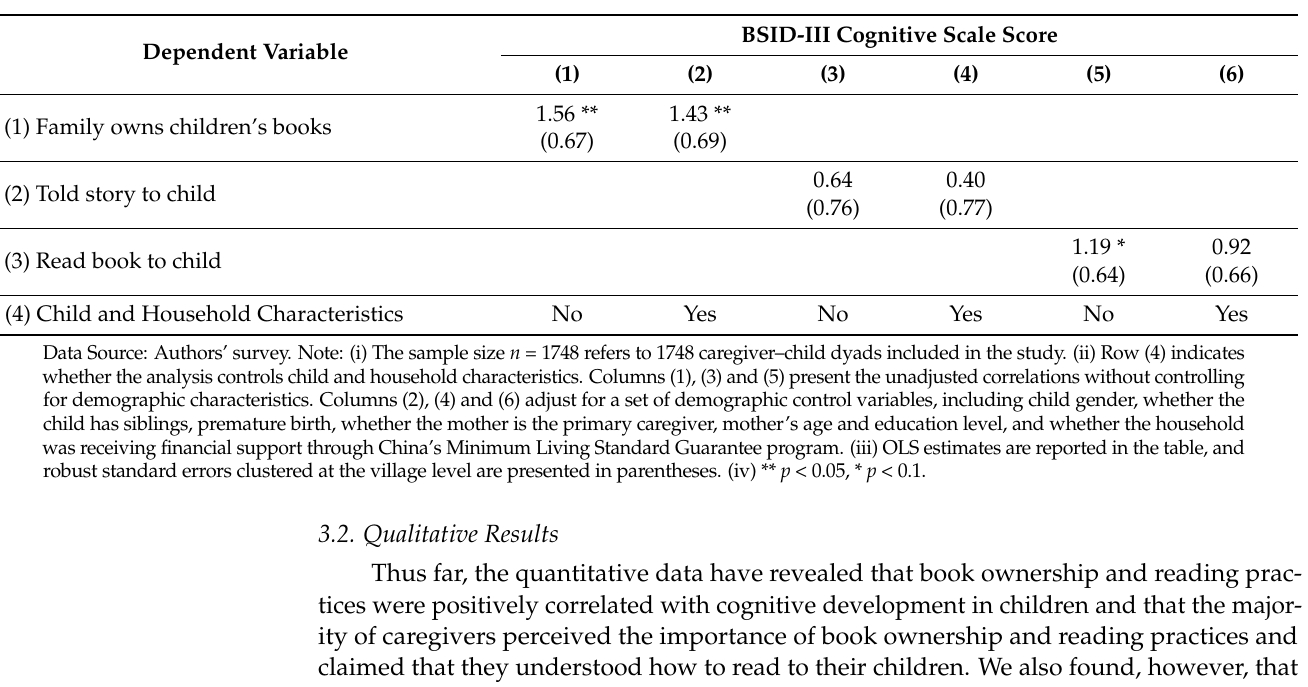
Table 5. Correlation of book ownership/reading behavior and cognitive development ( n =